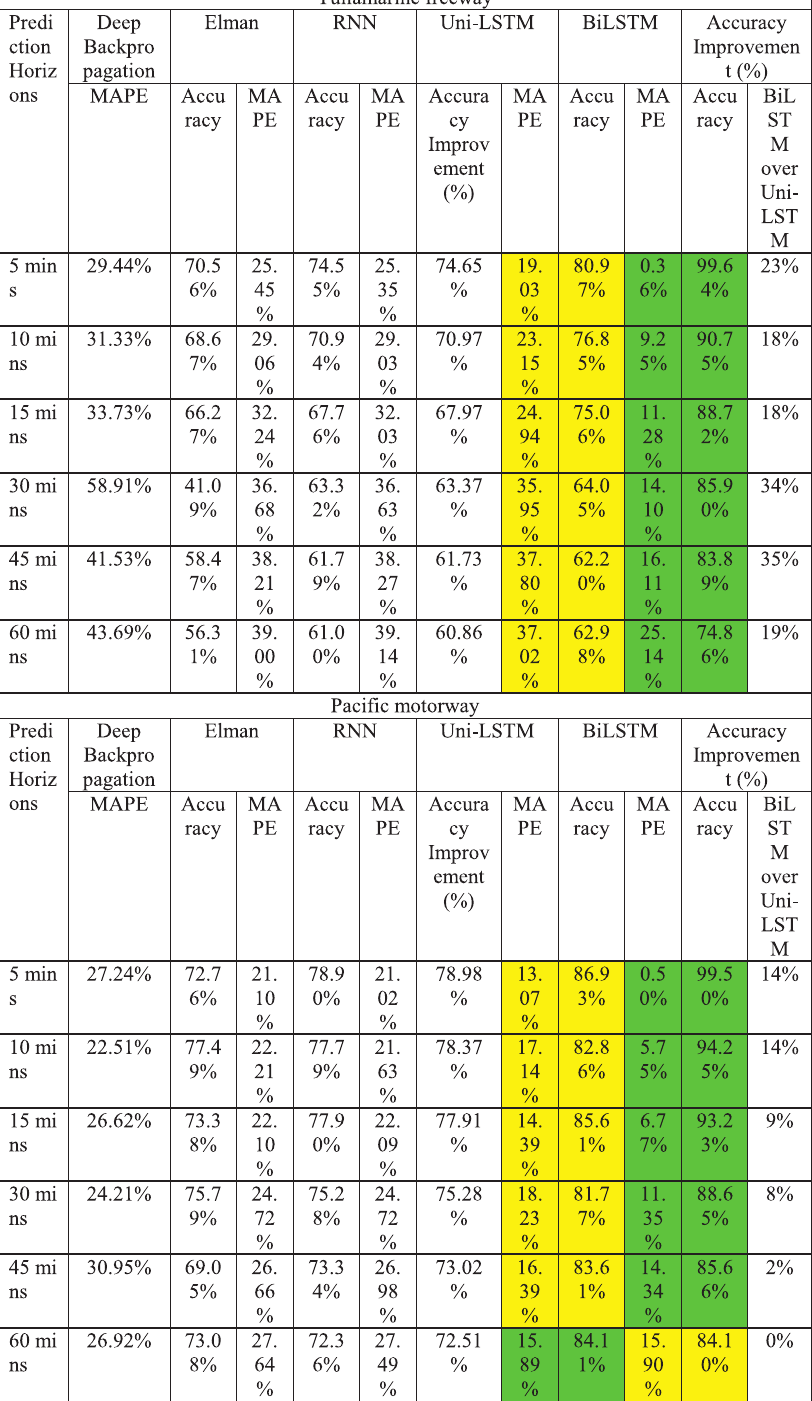
flow prediction models using data combined from the